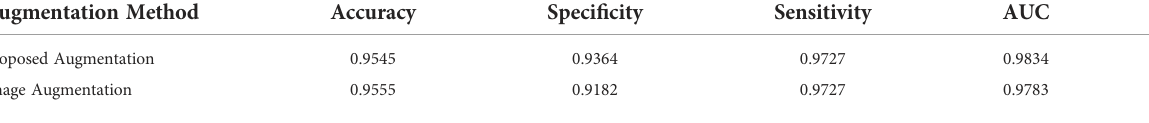
TABLE 1 Performance comparison between proposed augmentation and image